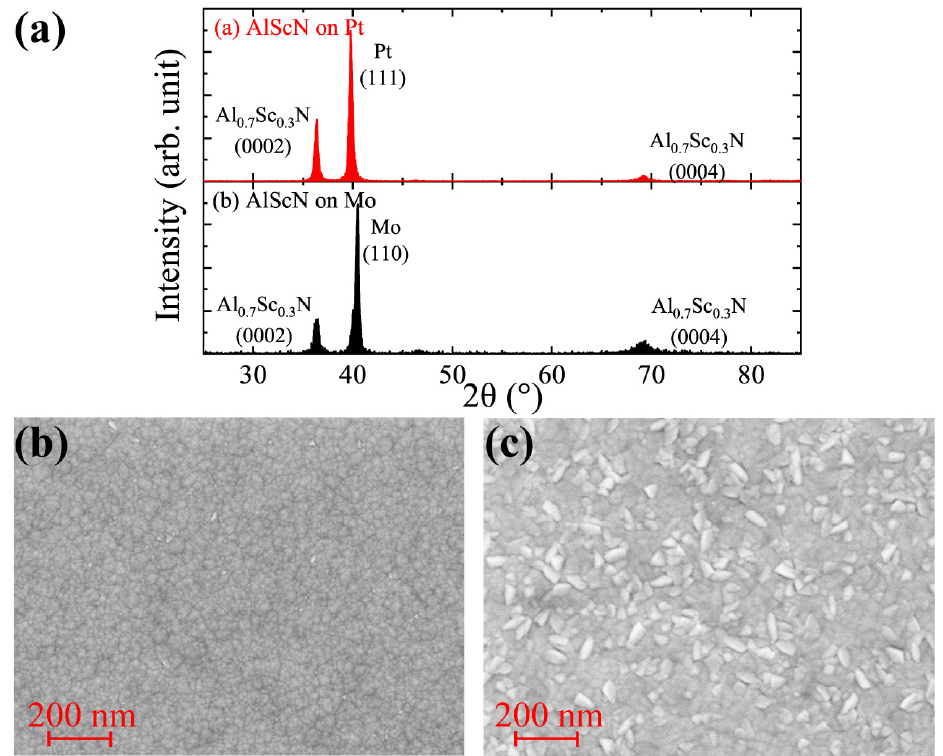
Figure 4. ( a ) X-ray diffraction 2 θ / θ scan Al 0.7 Sc 0.3 N on ( a ) Pt and ( b ) Mo. The peak of Al 0.7 Sc 0.3 N (0002) on the Pt sample is stronger than that of the Mo sample. SEM image of Al 0.7 Sc 0.3 N grown on: ( b ) Pt with a good crystal orientation; ( c ) Mo with a large number of abnormal grains.